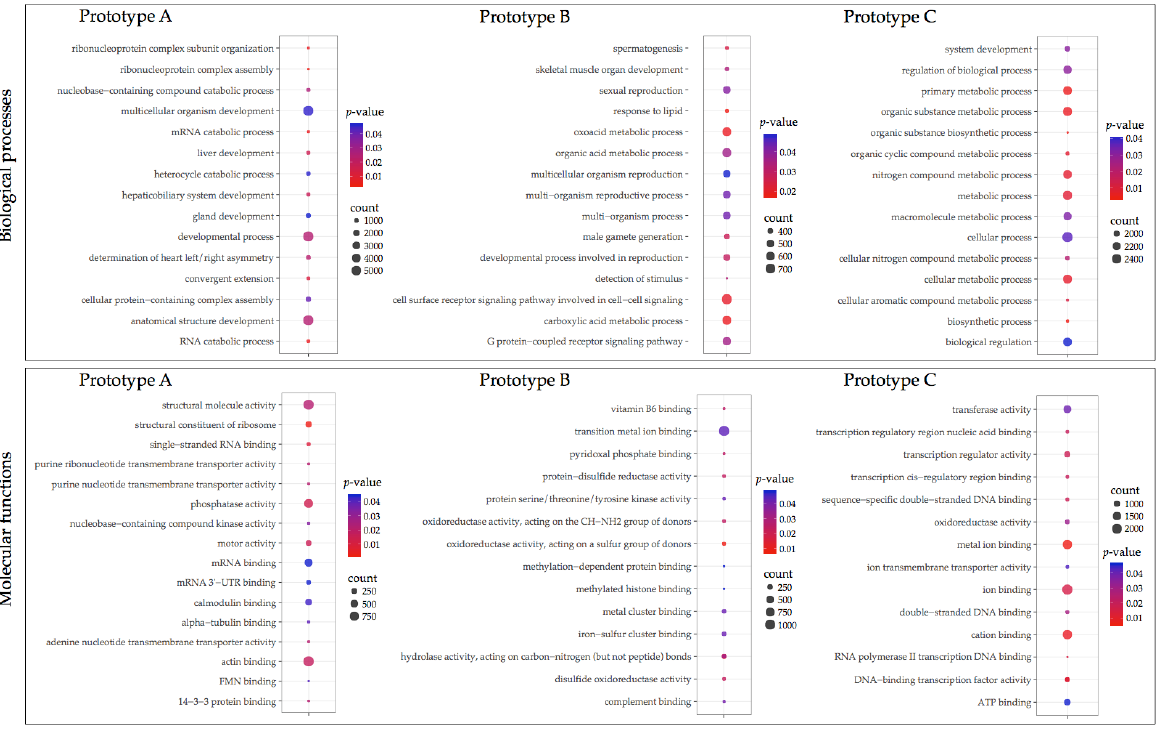
Figure 5. Gene ontology enrichment analysis of differentially expressed transcripts in the skin of vaccinated fish groups. The size of the circles indicates the number of transcripts that enriched the GO term. Colors indicate the p -value.